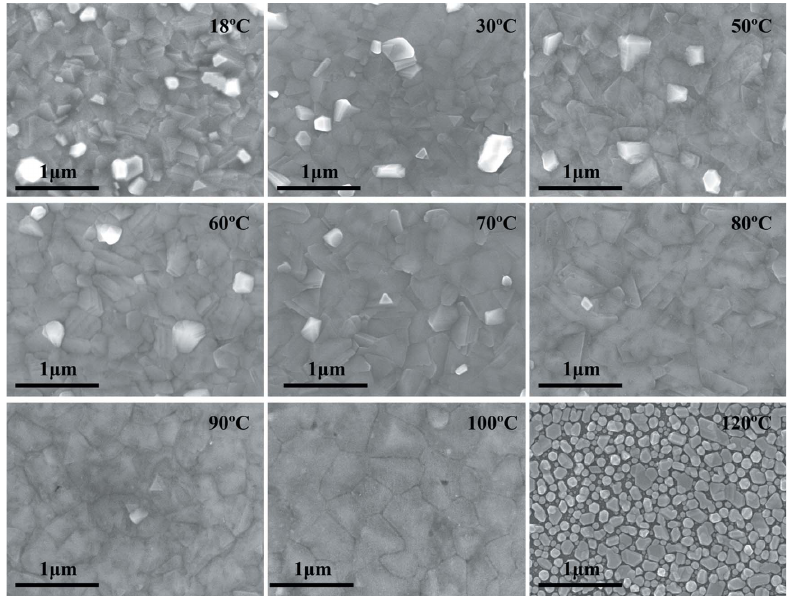
Figure 4 SEM images of Bi thin films at various substrate temperatures, i.e. 18, 30, 50, 60, 70, 80, 90,